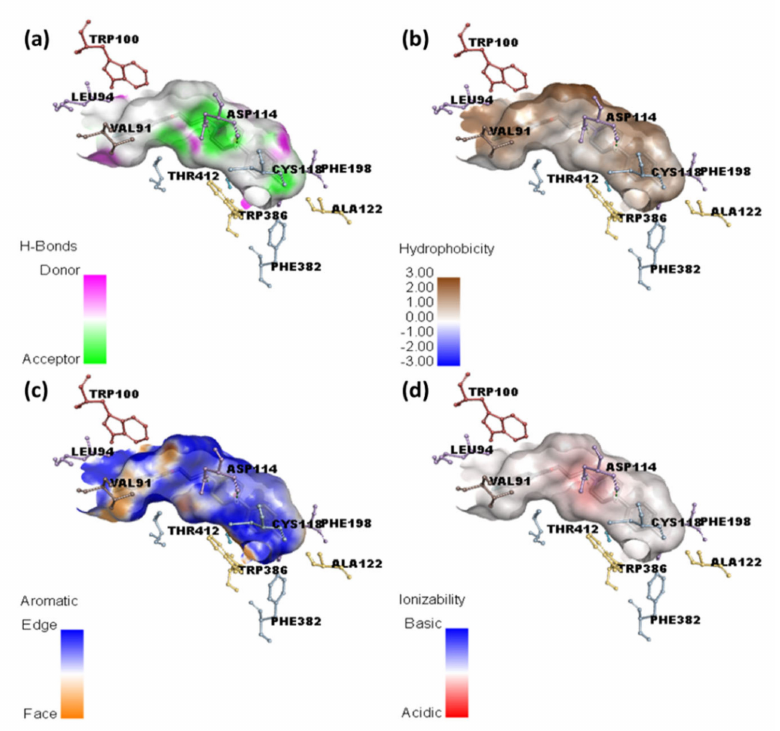
Figure 8. Representation of ( a ) hydrogen binding, ( b ) hydrophobic, ( c ) aromatic, and ( d ) ionizability surfaces between dopamine and HPL drug